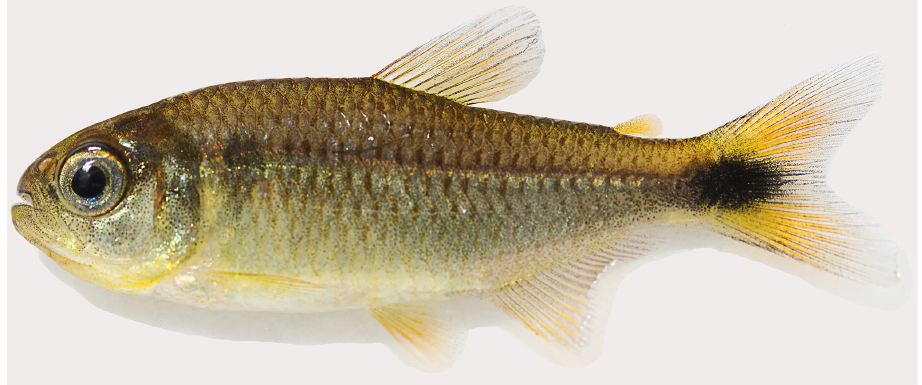
FIGURE 4 | Live coloration of Moenkhausia cambacica , paratype, MZUSP 125793, Brazil, Rondônia State, Municipality of Vilhena, rio Madeira basin, upper rio Machado drainage.